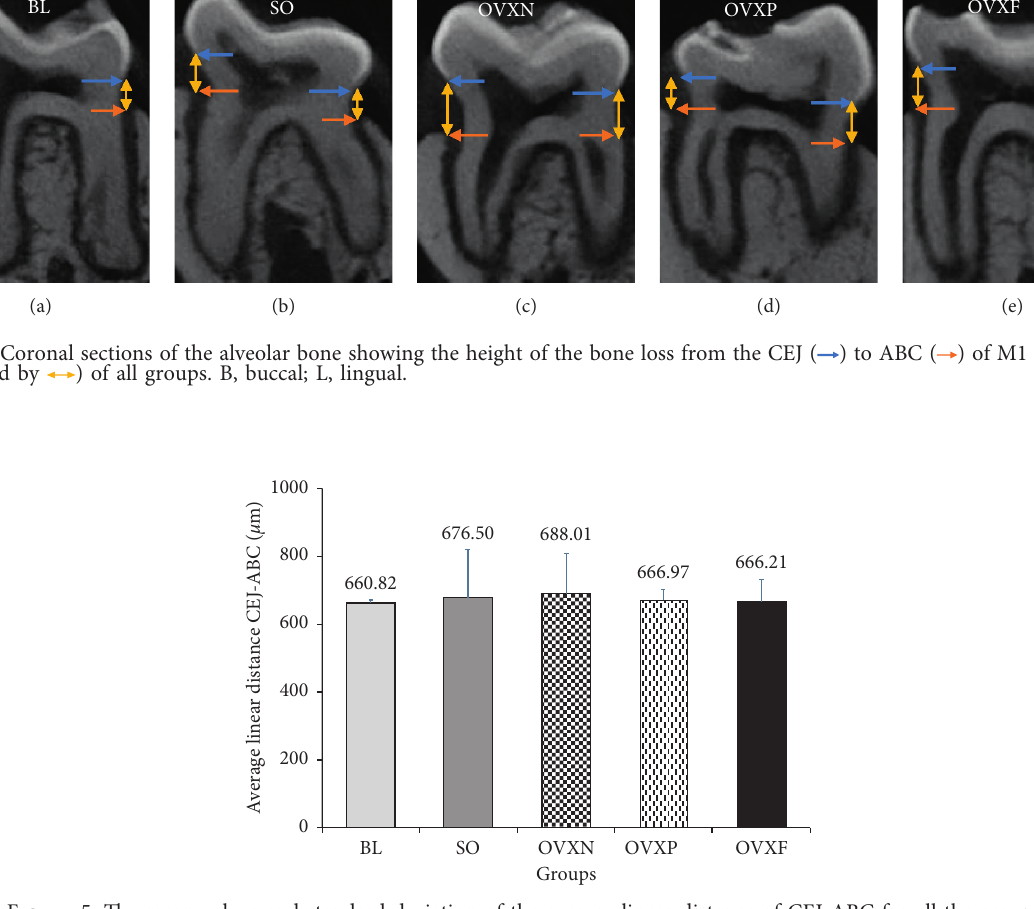
Figure 5: The mean values and standard deviation of the average linear distance of CEJ-ABC for all the